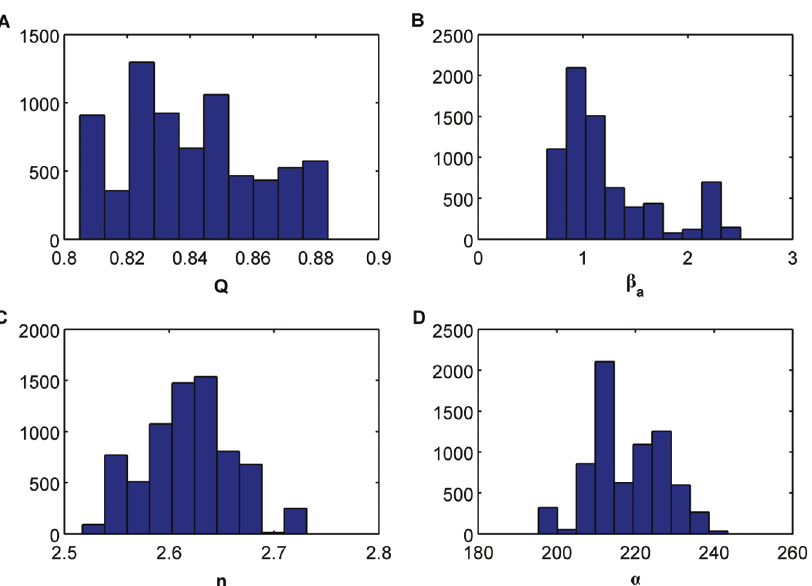
Figure 4. Histograms of the approximate marginal posterior distributions for each parameter for the ABC MCMC algorithm when considering E ~ 0 : 001 . (A) Q , (B) b a , (C ) n and (D) a .